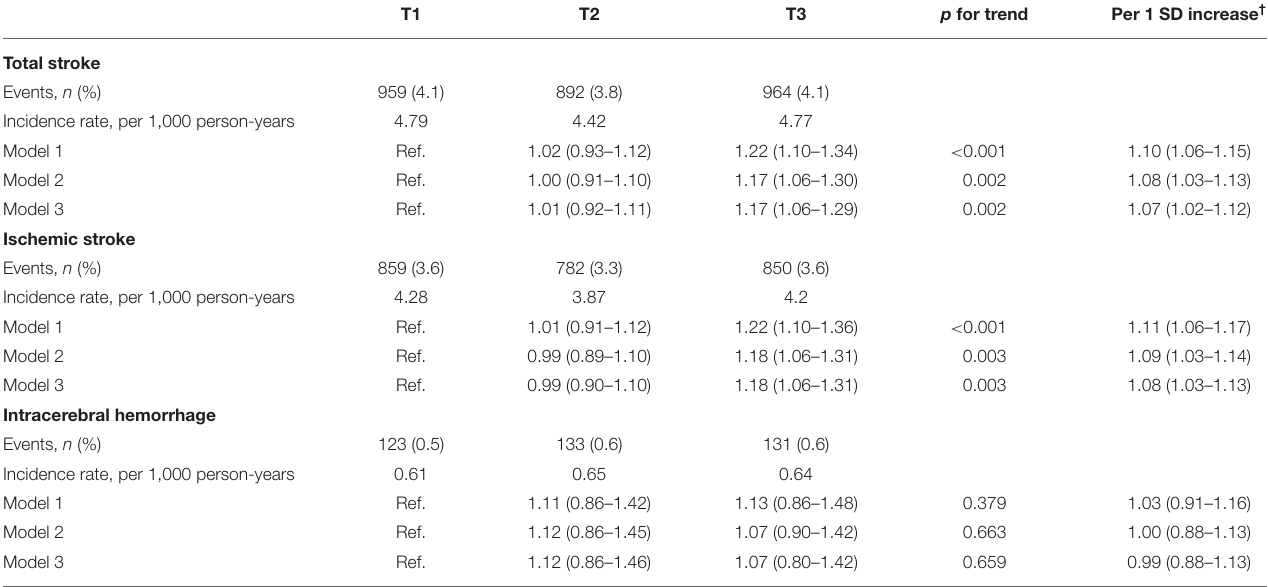
TABLE 2 | Hazard ratios (HR) for stroke according to the tertile of 2-year TC change. T1 T2 T3 p for trend Per 1 SD increase